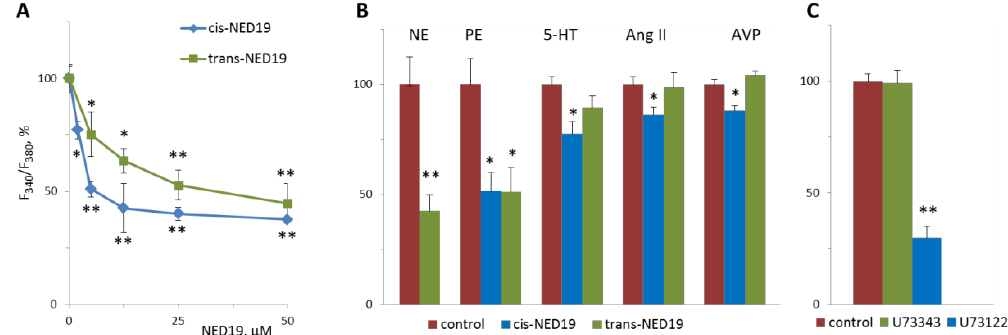
Figure 4. The e ff ects of cis - and trans -NED 19 on the increase in [Ca 2 + ] i in SMCs in response to 100 µ M NE ( A ), 10 µ M NE, and 10 µ M phenylephrine (PE), 5-HT, Ang II, and AVP, ( B ) and the e ff ect of 1 µ M U73122 and U73343 on the increase in [Ca 2 + ] i in SMCs in response to 100 µ M NE ( C ). In panel B, the concentrations of the isomers of NED 19 were 50 µ M with PE and 25 µ M with 5-HT, Ang II, and AVP; the concentration of trans -NED 19 was 100 µ M with NE. The concentrations of 5-HT, Ang II, and AVP were as in the legend to Figure 3. Each value is a mean of four to six measurements in di ff erent cell preparations + SEM. There is significant di ff erence from control (* p < 0.05, ** p <